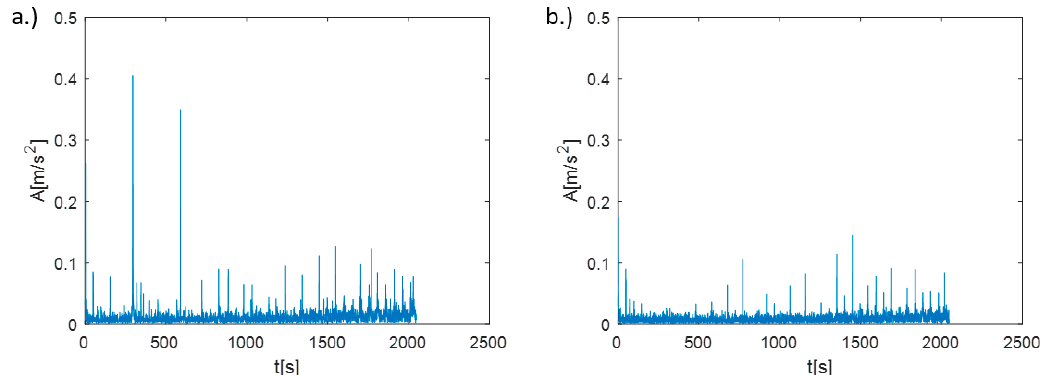
Figure 10. The FFT of vibrations measured during the machining, test “1”: ( a ) section 1, ( b ) section 2.